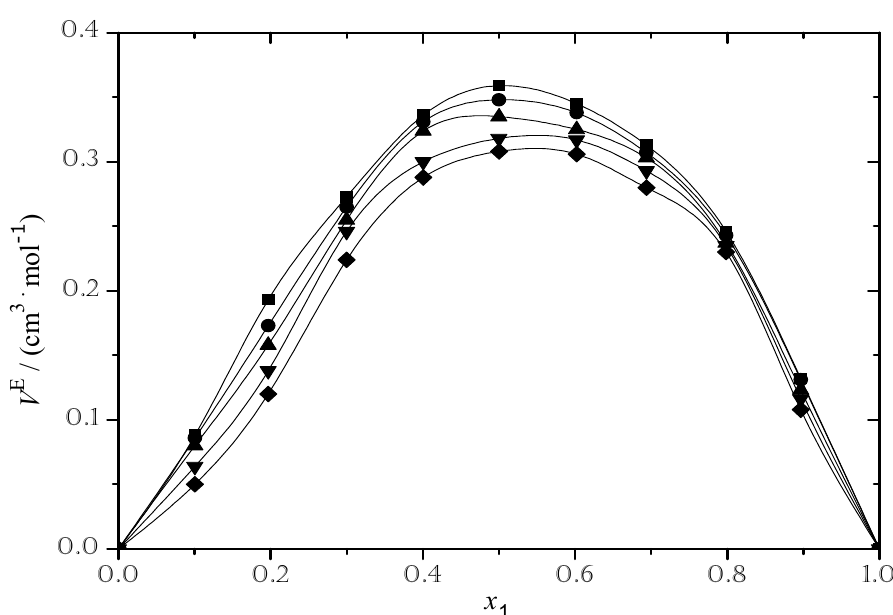
Figure 2. Excess molar volumes ( V E ) with mole fraction for MDEA (1) + DMSO (2) system at various temperatures: ■ 293.15 K; ● 298.15 K; ▲ 303.15 K; ▼ 308.15 K; ♦ 313.15K.